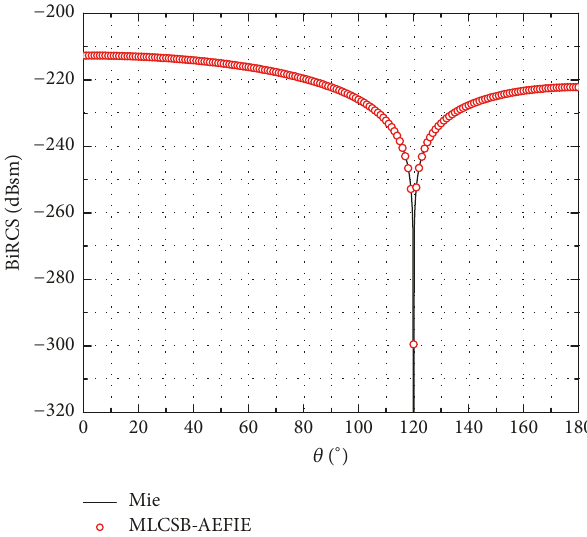
Figure 1: Bistatic RCS of the PEC sphere at 100 Hz, validated by the Mie